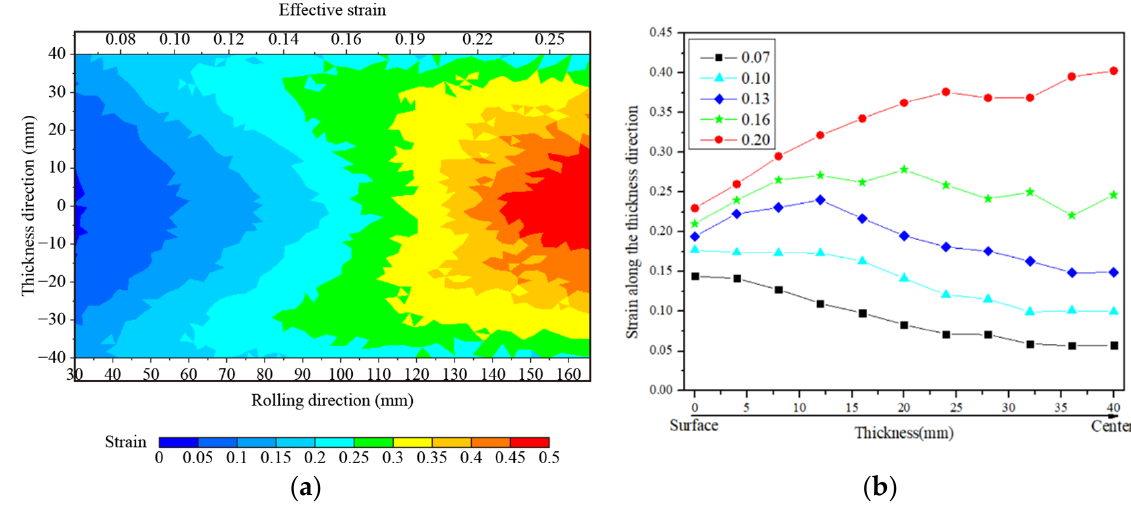
Figure 13. Distribution of strain: ( a ) cloud map of strain distribution; ( b ) plastic strain along the thickness direction with different reduction amounts.